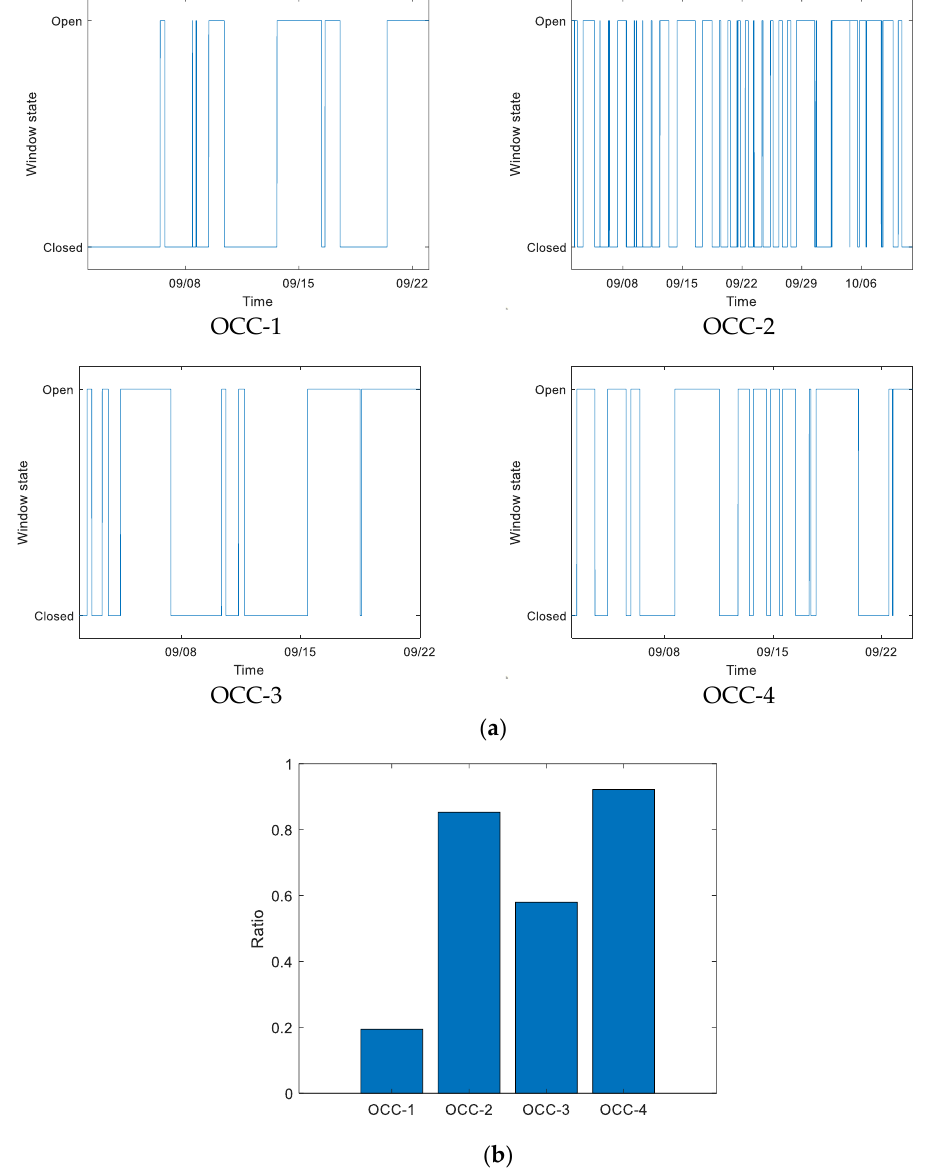
Figure 2. Monitored status of four rooms. ( a ). Window opening/closing time. ( b ). daily average occupancy rate.